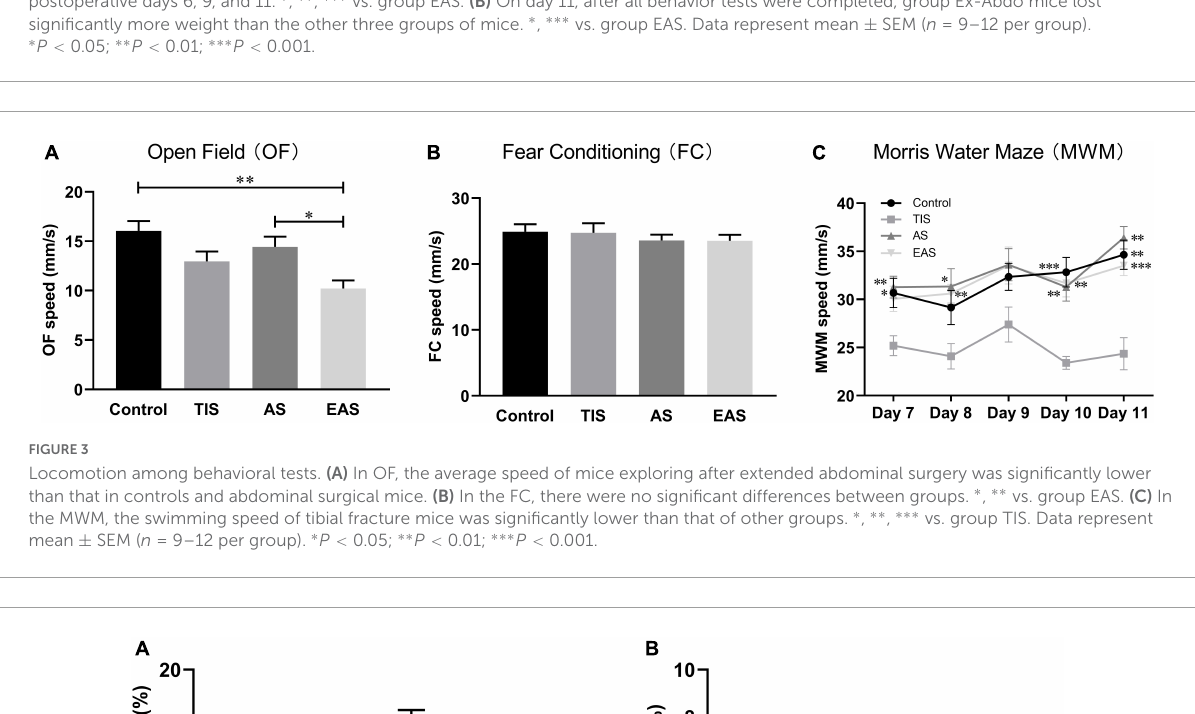
It has been reported that hippocampal pro-inflammatory factors significantly increased at 24 h, rather than 7 days